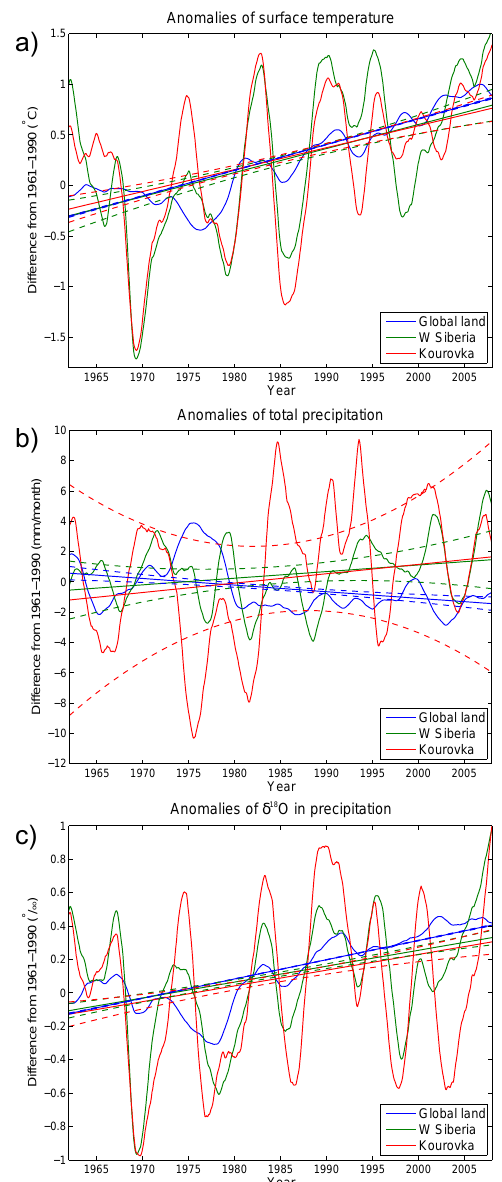
Figure 6. Simulated time series of (a) surface temperature, (b) pre- cipitation, and (c) δ 18 O in precipitation for the period 1962–2008. Shown are anomalies from the climatological mean (reference pe- riod: 1961–1990). The ECHAM5-wiso results are averaged glob- ally (blue line), for the region of western Siberia (green line), and interpolated to the location of Kourovka Observatory (red line). A zero-phase bidirectional low-pass filter with a length of 24 equally weighted months has been applied to the simulated monthly mean values for filtering short-term fluctuations. Straight lines are global (blue), regional (green) and local (red) trends obtained from least- square fits of annual-mean values for the period 1960–2010; dashed lines are 95% confidence intervals for the trends. See also Table 2 for a summary of numerical